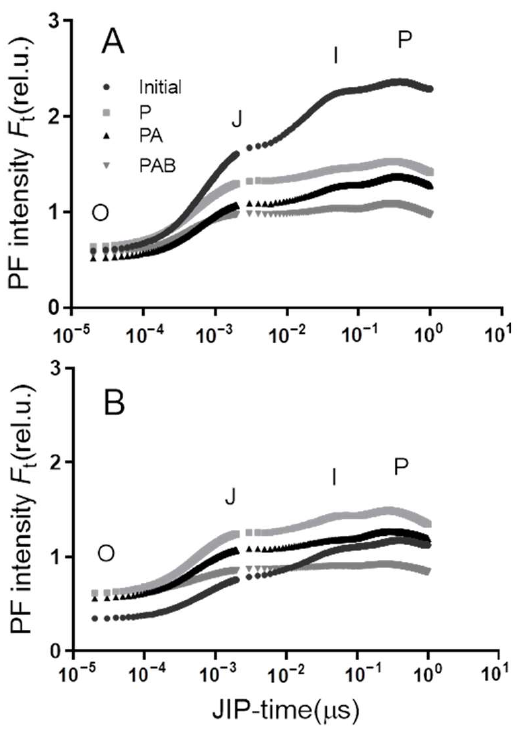
Figure 5. Chlorophyll a fluorescence transients (OJIP) of Sargassum horneri under LN ( A ) and HN ( B ) under P, PA, and PAB treatments. Significant differences among all treatments are indicated by different lowercase letters ( p < 0.05).